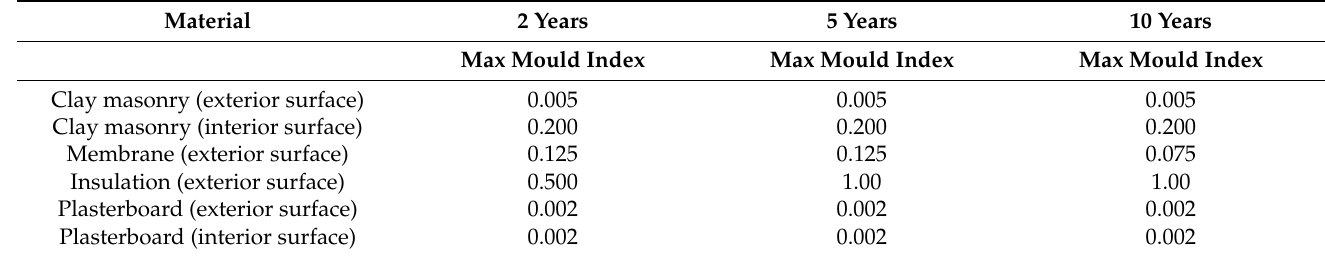
Table 13. Mould growth simulation results for the 7-star clay masonry veneer wall—eastern orientation.